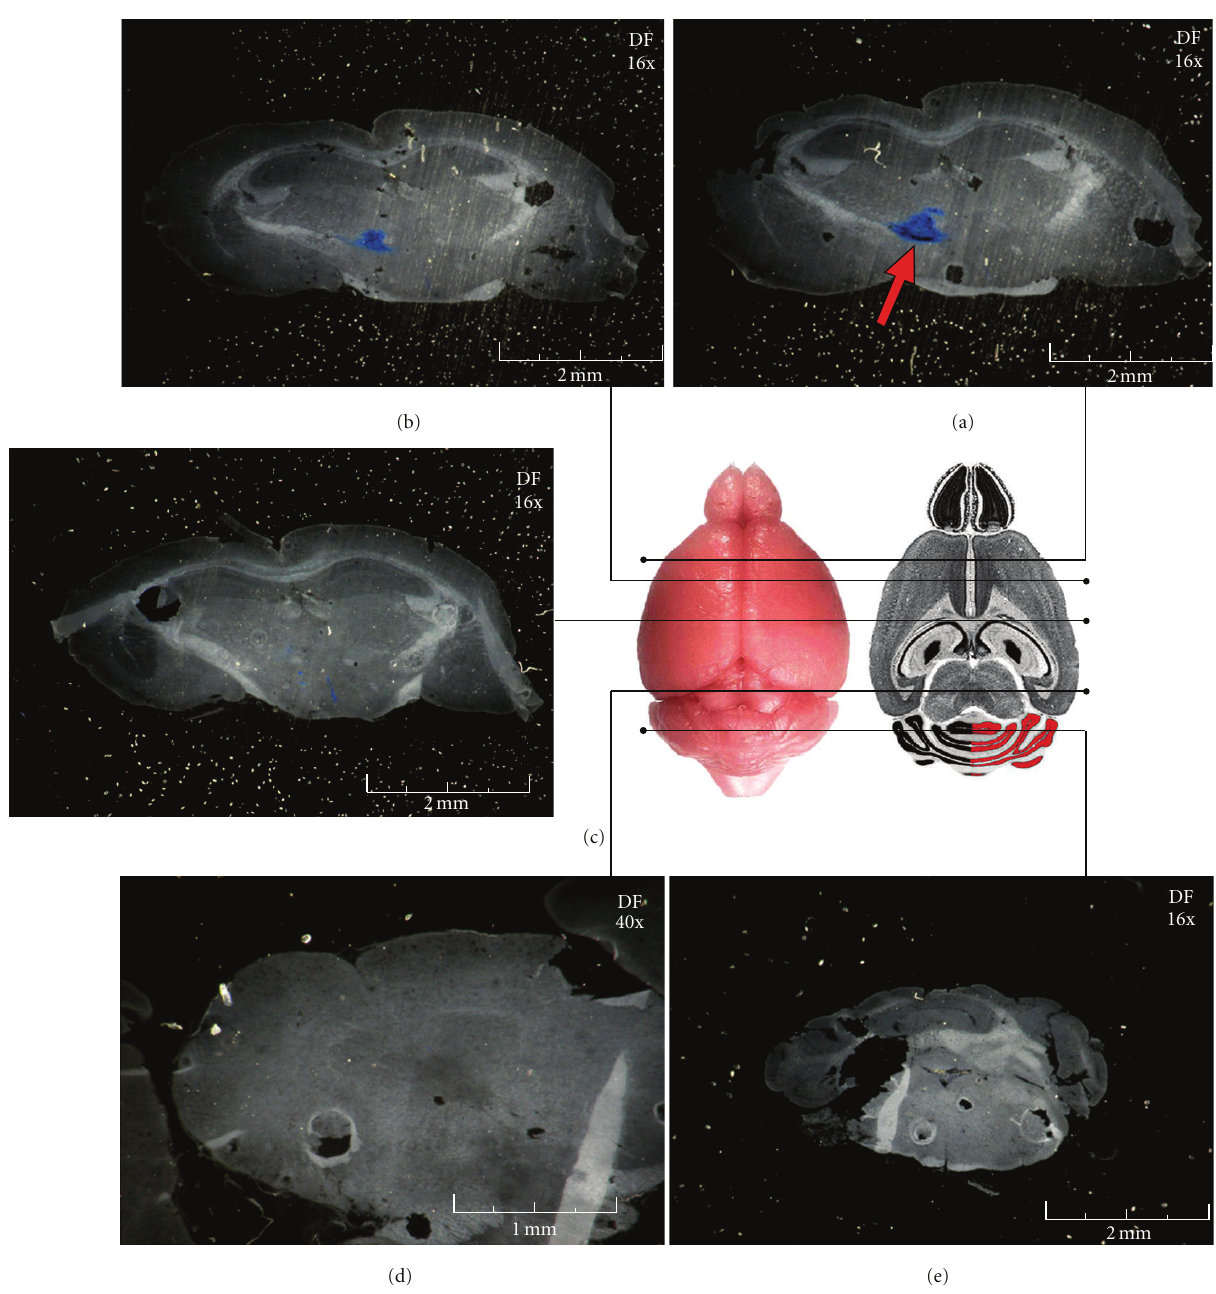
Figure 6: Representative sections of HSV-T0Z distribution in the mouse central nervous system. Serial brain sections were produced dissecting animals in coronal orientations (a–e). Here, we show a part of the representative coronal sections. Sections were stained with the X-Gal substrate (blue signal) as described in method paragraph. In the dark field (DF) images are indicated the magnification and measurement bars. Point of injection is shown (red arrow) into image (a) on the left hemisphere close to bregma line. In (e) there is a representative section of